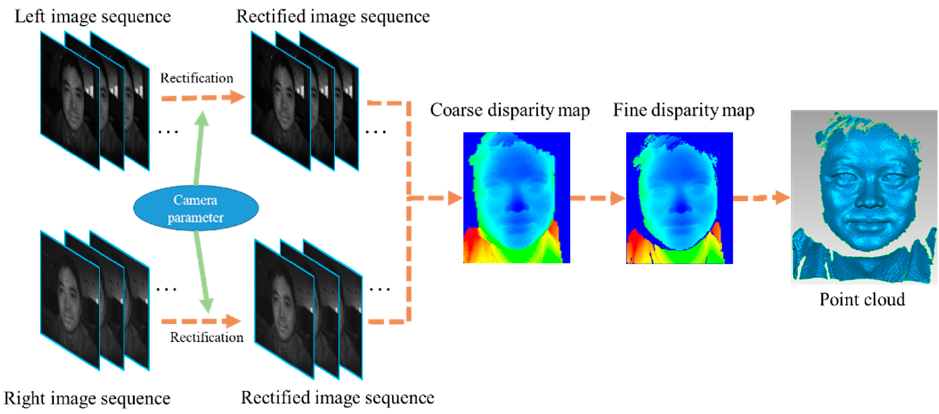
Figure 4. Block diagram of the fast stereo-matching method for 3D face reconstruction.